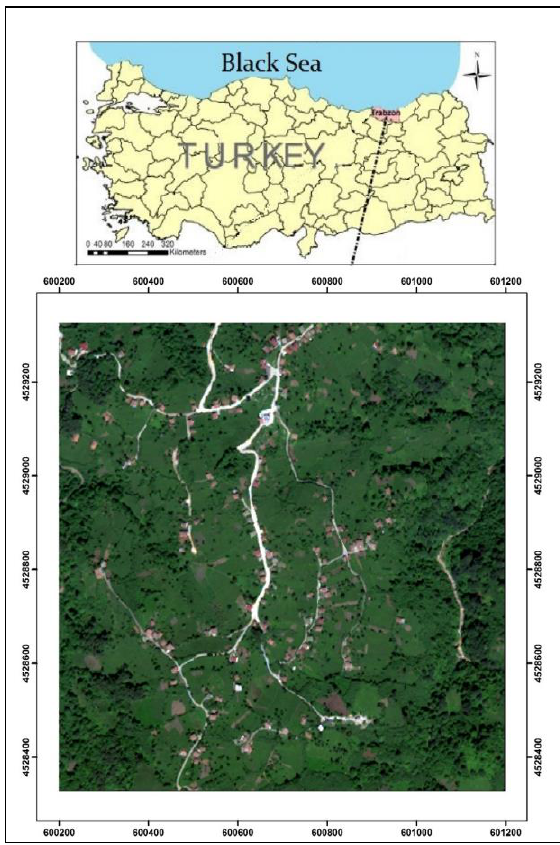
Figure 1. Study area in Kumru district of Surmene